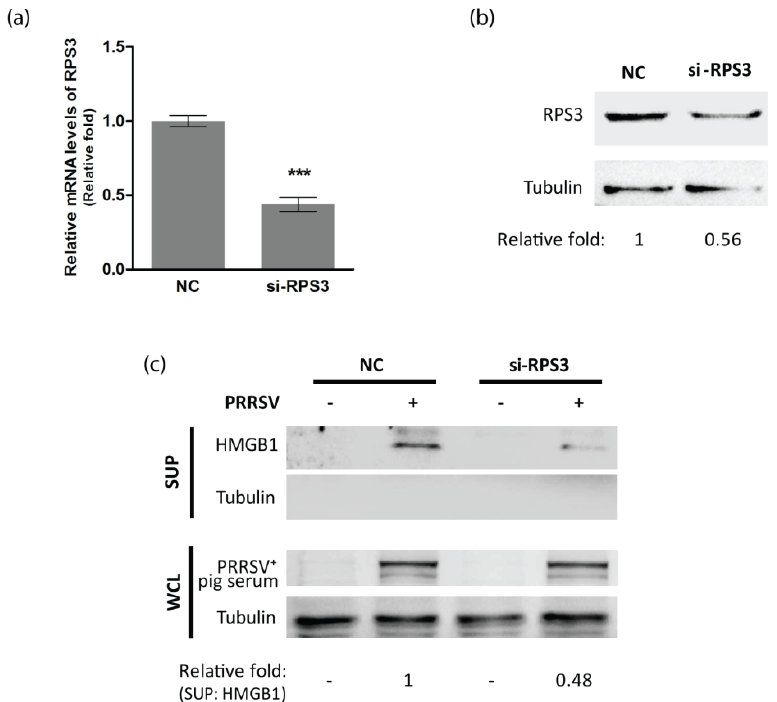
Figure 5 . Silencing of RPS3 diminishes the HMGB1 secretion induced by PRRSV infection. (a&b) RPS3 mRNA and protein levels in cells transfected with siRNA control (NC) or siRNA against RPS3 (si-RPS3). MARC-145 cells were transfected with NC or si-RPS3 (100 nM) and, 48 h later, were harvested for RT-qPCR ( a ) and IB ( b ). Significant differences are denoted by “***” for p < 0.001. ( c ) Silencing of RPS3 reduces the HMGB1 secretion induced by PRRSV infection. MARC-145 cells treated with NC or si-RPS3 for 24 h were infected with HuN4 at an MOI of 1. The SUP and WCL were harvested at 24 hpi for IB with antibodies against HMGB1 and tubulin. PRRSV + pig serum was also used in IB for detecting PRRSV infection. Relative levels of HMGB1 in SUP are shown as folds below the images.